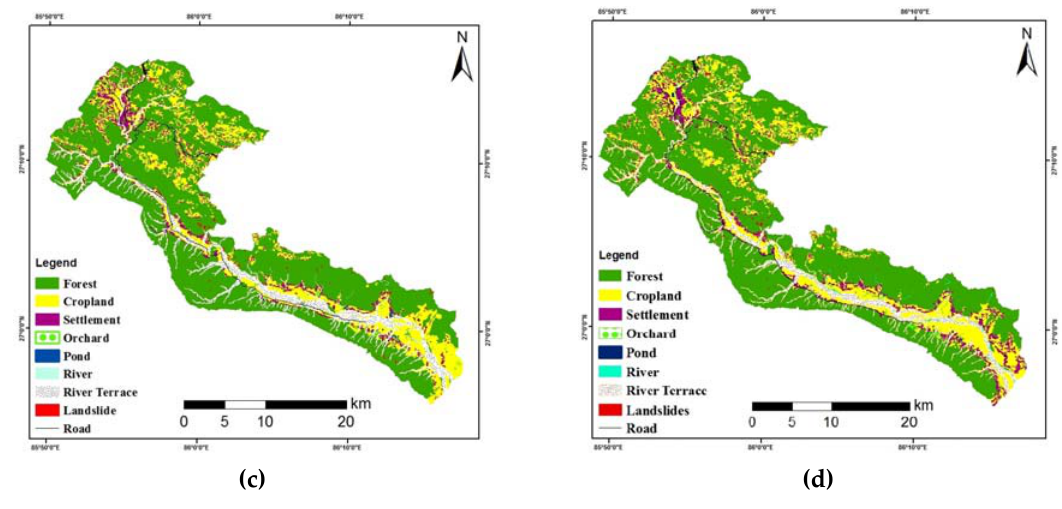
Figure 3. Land use maps of ( a ) 1995; ( b ) 2005; ( c ) 2010; and ( d ) 2014. Table 3. Land use area in hectare and percentage coverage (1995–2014).